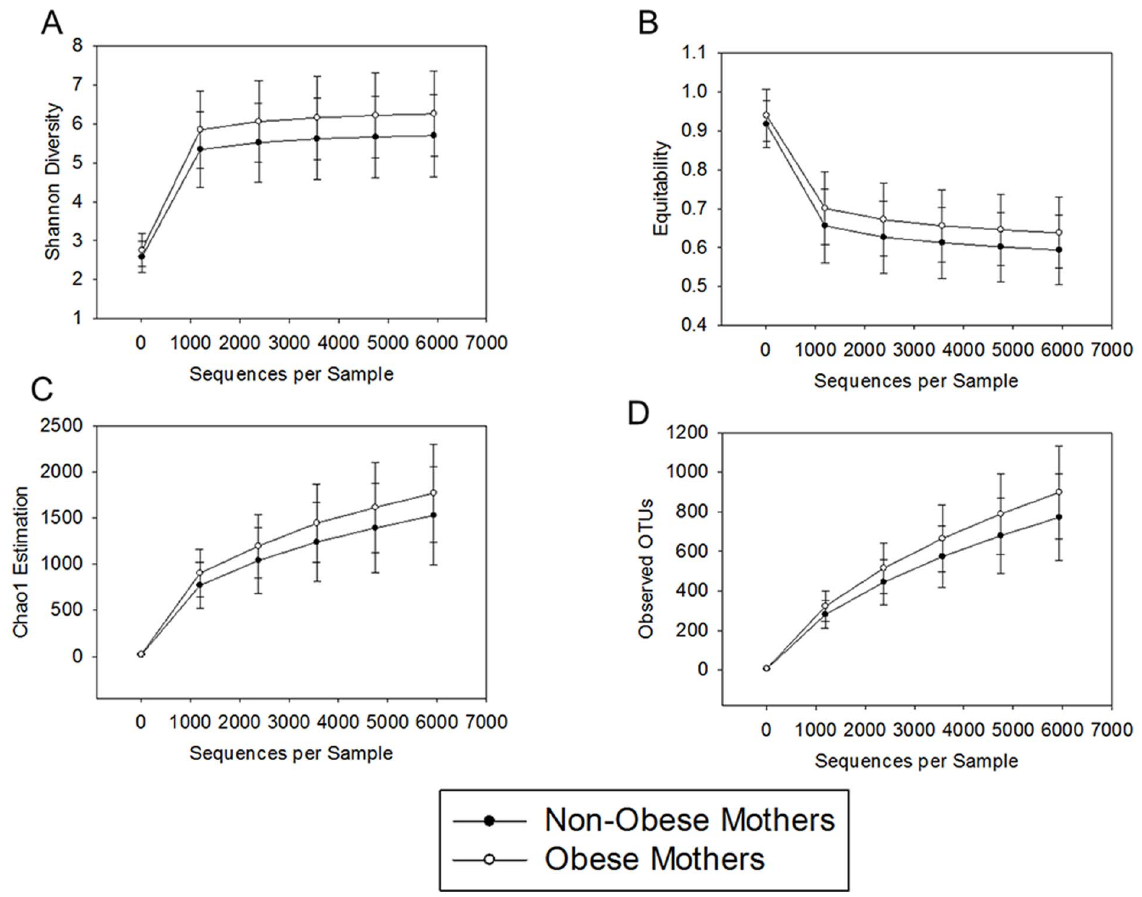
Figure 3. In the overall sample, children born to obese versus non-obese mothers had significantly greater alpha diversity as indicated by A) Shannon Diversity Index (SDI), a measure of overall alpha diversity; B) equitability, a measurement of evenness; C) Chao1, an estimation of richness; and D) the total observed operational taxonomic units (OTUs) ( p s , .05; Means ± 1 SE).